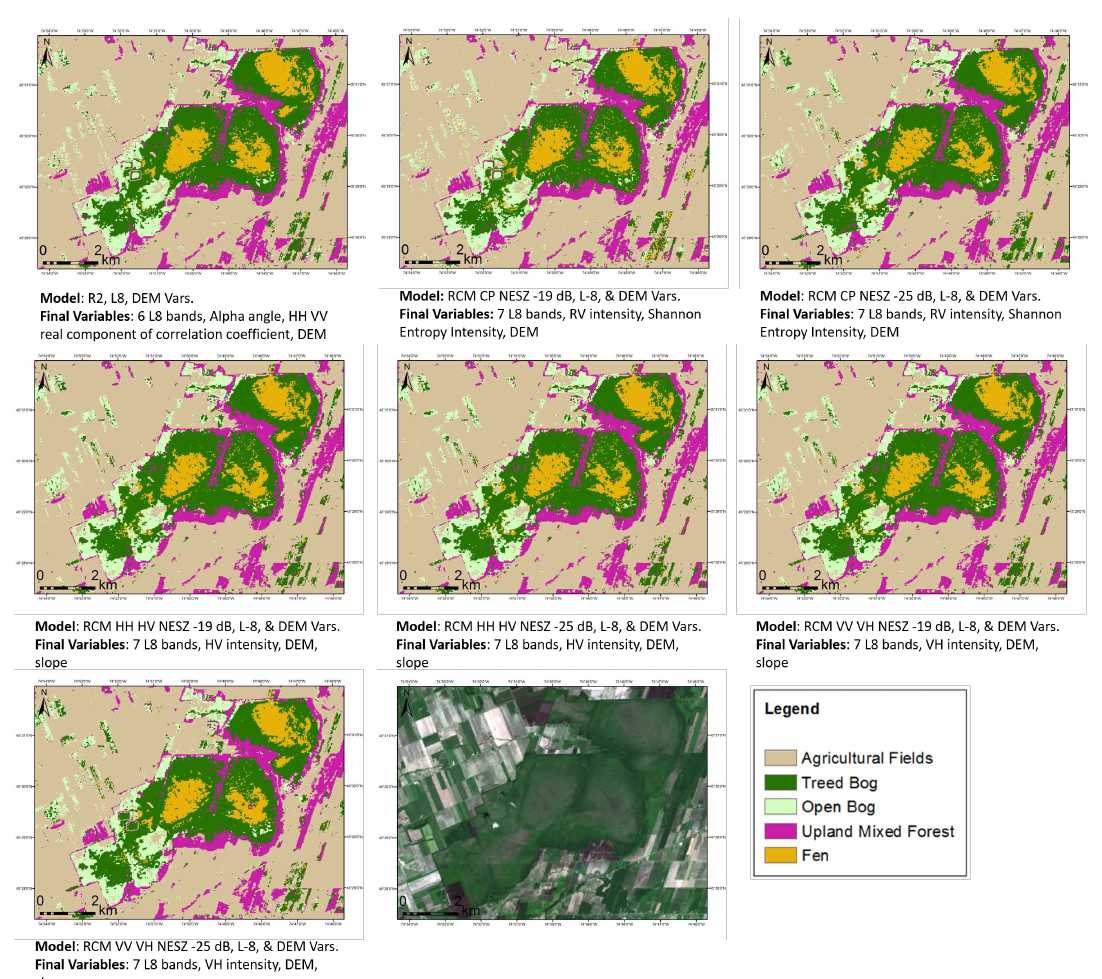
Figure 6. Classification results from the summer RF classifications. Models presented here were those with the highest overall independent accuracy after variable reduction. A Landsat-8 image from 27 June 2014 was included for